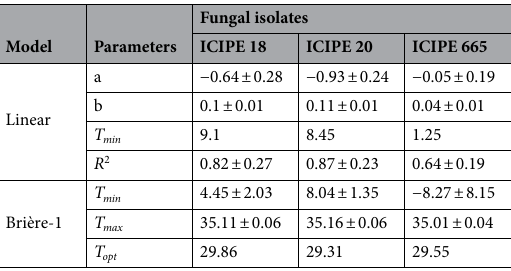
(Table 1). The Brière-1 nonlinear model had a good fit to the data and predicted a lower temperature threshold of 4.45, 8.04 and −8.27 °C, for ICIPE 18, ICIPE 20 and ICIPE 665, respectively. The upper temperature thresh- old ( T max ) was 35.11, 35.16 and 35.01 °C, for ICIPE 18, ICIPE 20 and ICIPE 665, respectively with an optimum temperature of 29.86, 29.31 and 29.55 °C, for ICIPE 18, ICIPE 20 and ICIPE 665, respectively (Table 1). Using the linear model, T min of the fungal isolates was estimated at 9.1 °C, 8.45° and 1.25 °C for ICIPE 18, ICIPE 20 and ICIPE 665, respectively. The optimum temperature threshold ( T opt ) was estimated at 29.86, 29.31 and 29.55 °C for ICIPE 18, ICIPE 20 and ICIPE 665, respectively (Table 1). The linear regression model showed a strong posi- tive relationship between temperature and radial growth rate ( R 2 = 0.82 and R 2 = 0.87 for ICIPE 18 and ICIPE 20, respectively) (Table 1).